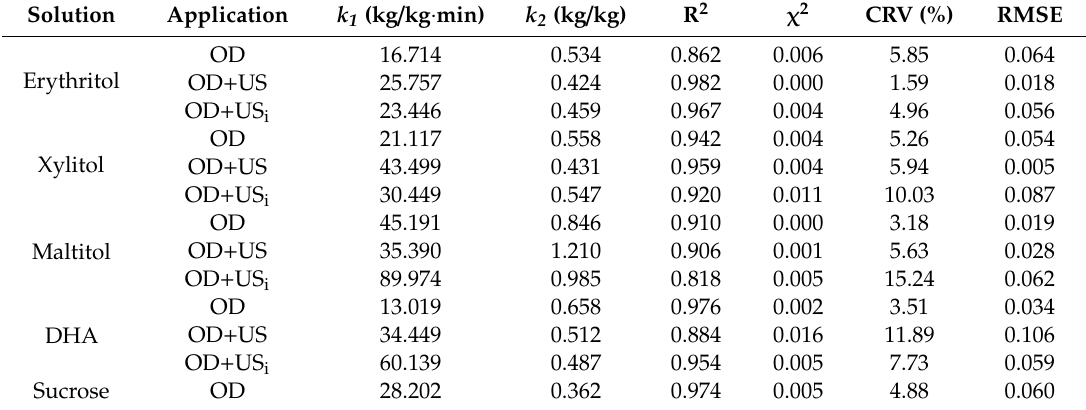
Table 4. Values of k 1 , k 2 , R 2 , χ 2 , coe ffi cient of residual variation (CRV), and RMSE of modelling WL using Peleg’s model. RMSE: root mean square